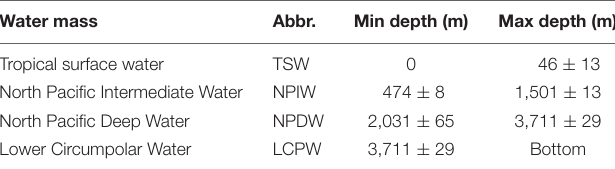
TABLE 2 | Water mass structure of the eastern German License area. Water mass